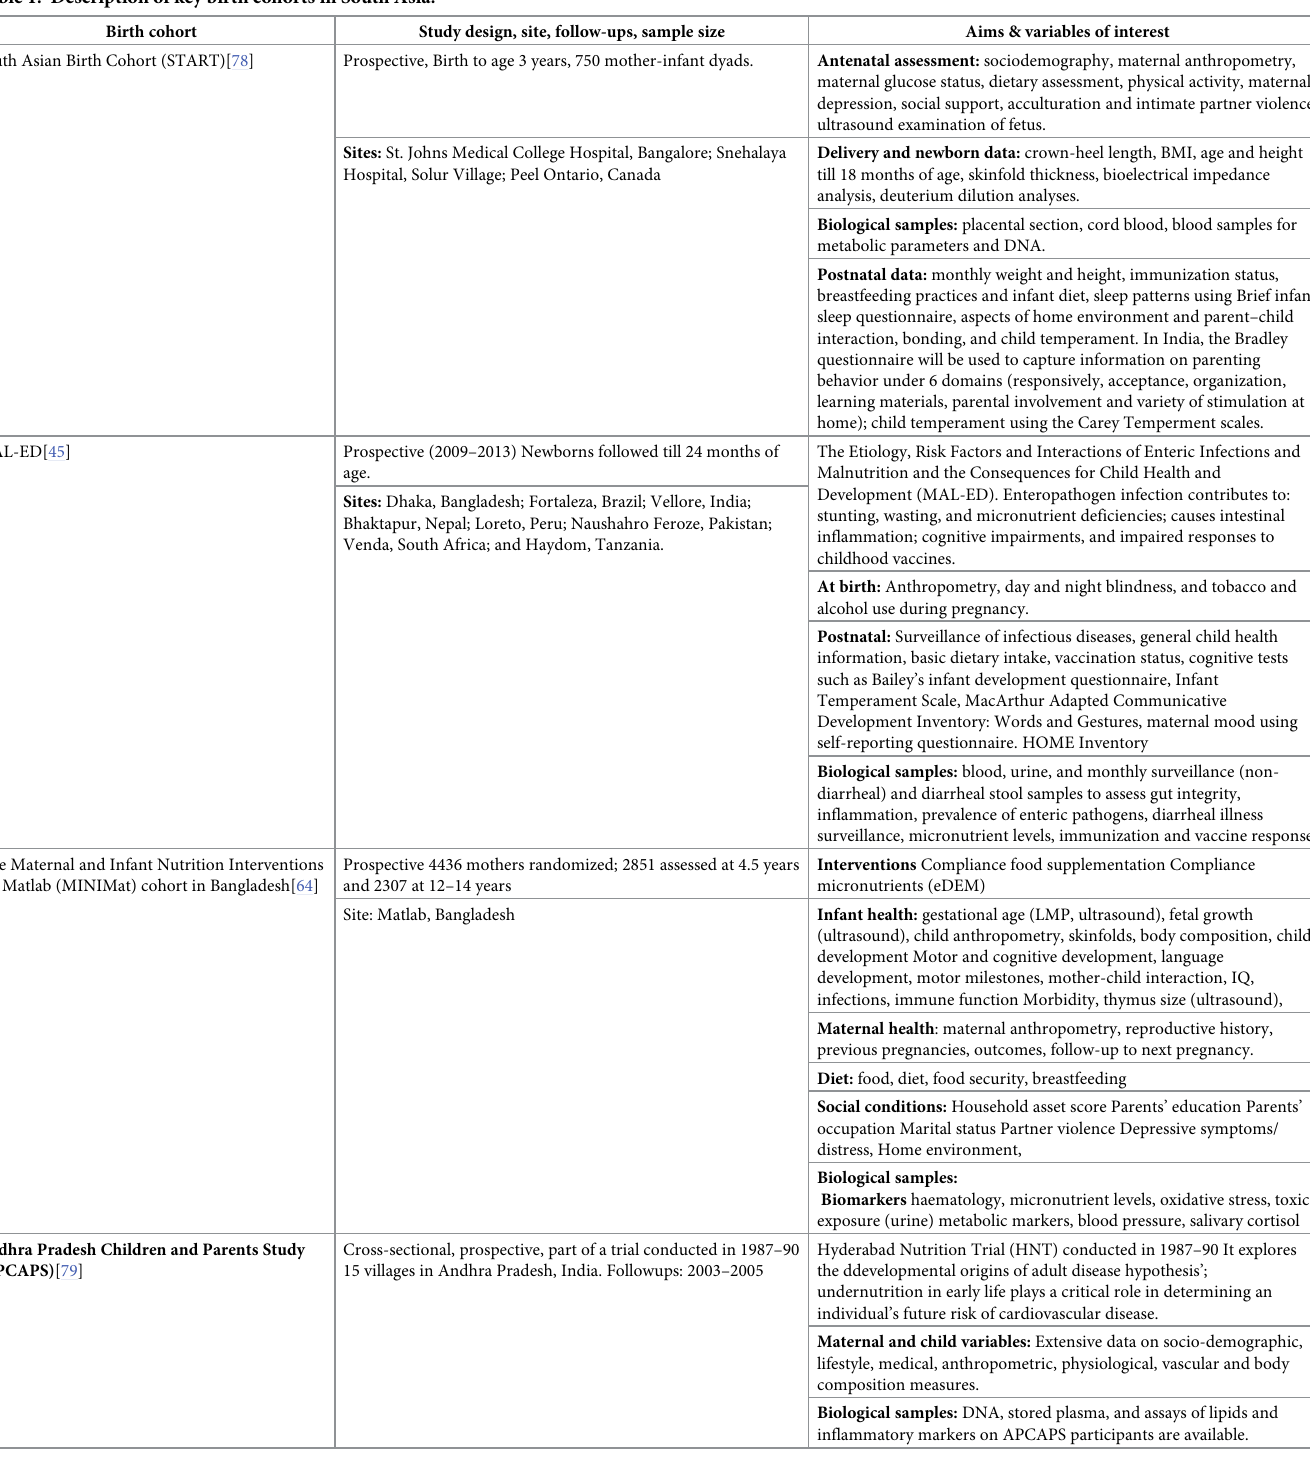
Table 1. Description of key birth cohorts in South Asia. Birth cohort Study design, site, follow-ups, sample